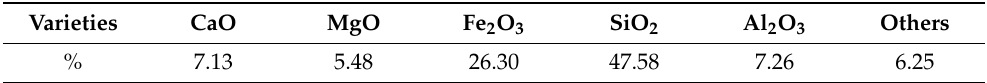
Table 1. Chemical composition of